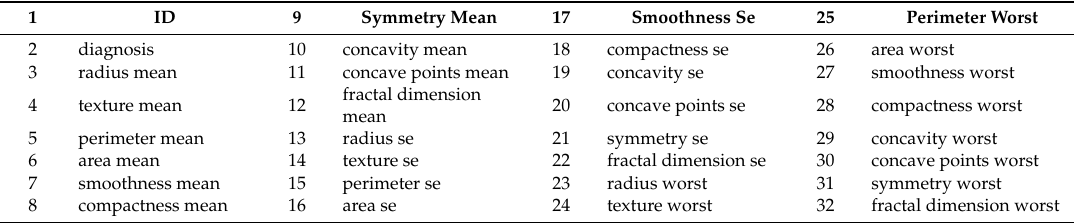
Table 2. Wisconsin breast cancer